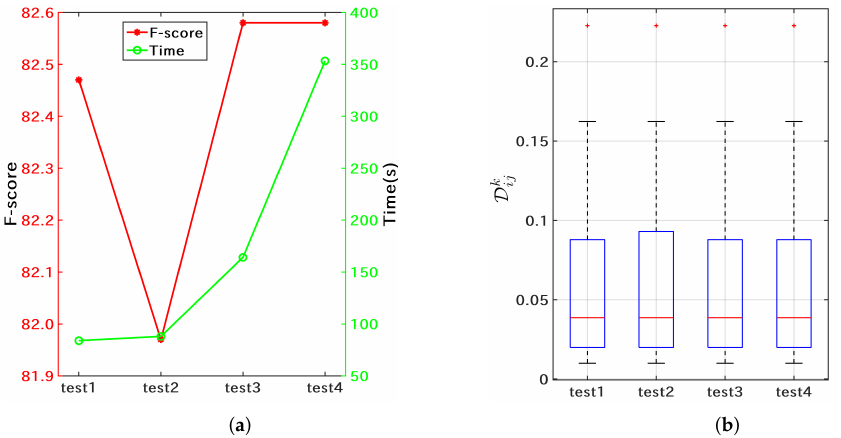
Figure 11. Template matching performance on the GISAID training set S G and the training time (green) for each of the tests; ( b ) difference statistics for misclassified